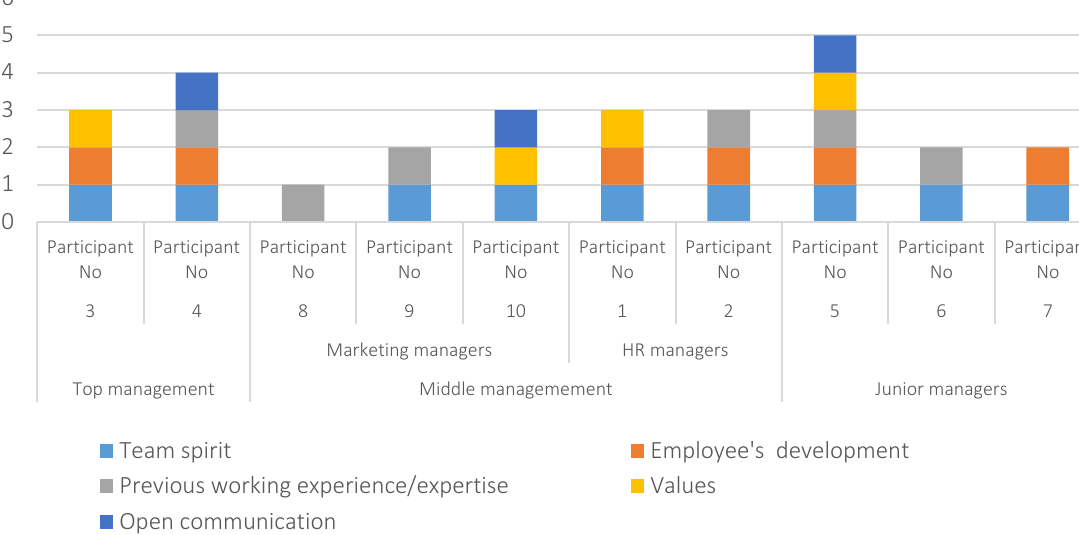
Figure 3a. Internal marketing and promotion of the desired behavior/executives’ perceptions